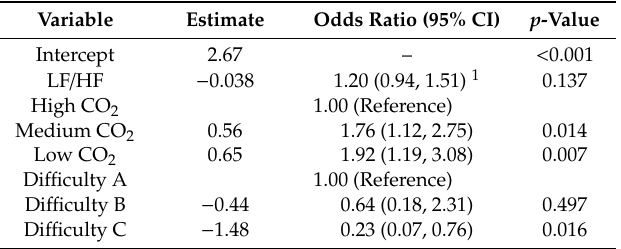
Table 6. GAMM results of LF / HF, CO 2 condition and maneuver di ffi culty on passing a maneuver, controlling for examiner and flight profile number and treating pilot ID as a random e ff